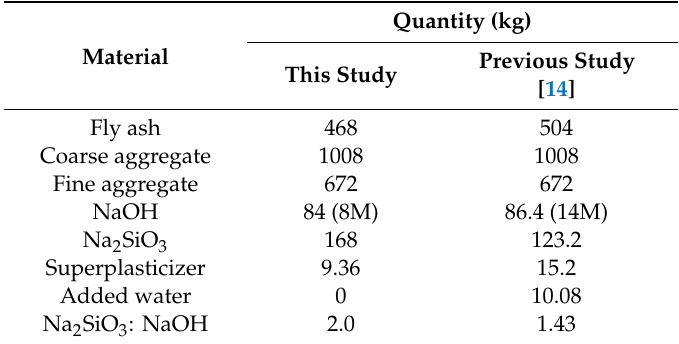
Table 2. Geopolymer concrete